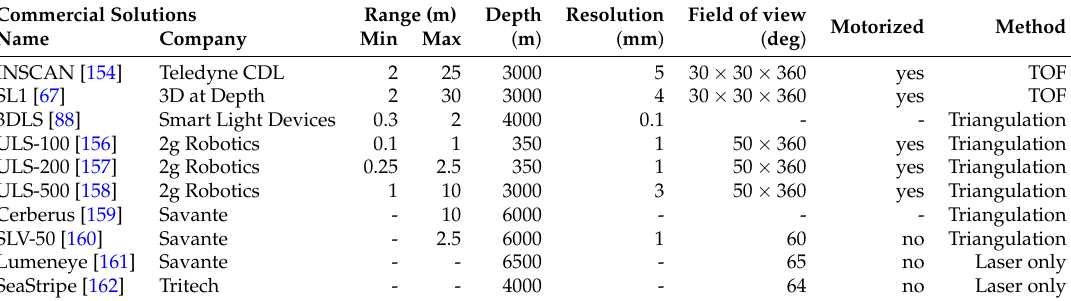
Table 7. Available commercial solutions to perform 3D